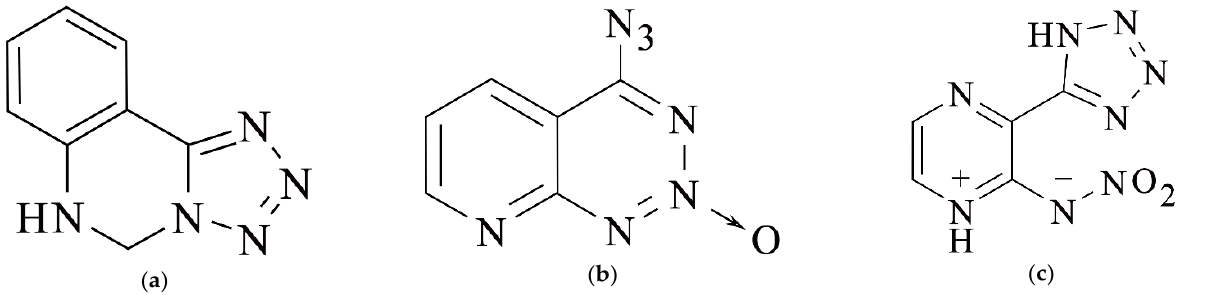
Figure 1. The chemical diagrams of three heterocyclic energetic molecules: ( a ) molecule a ; ( b ) molecule b ; ( c ) molecule c .